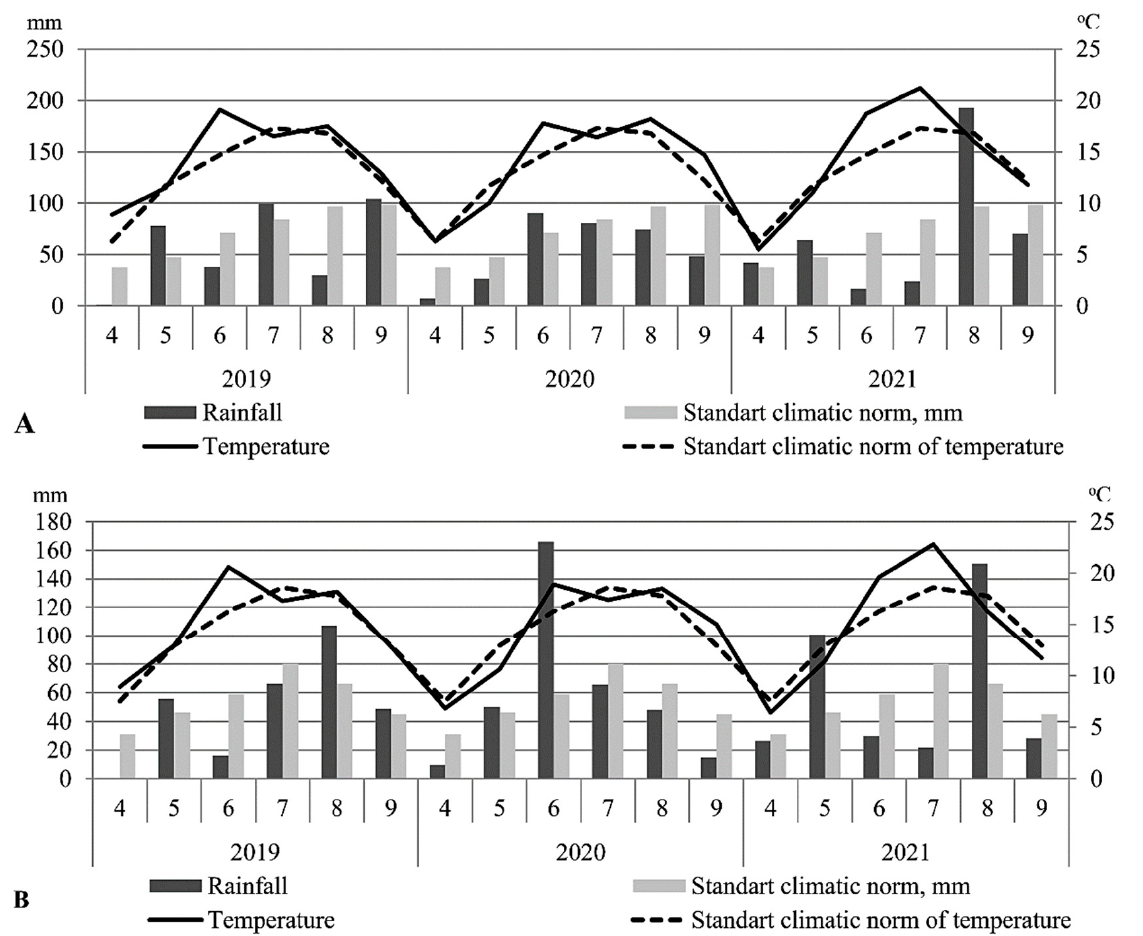
Figure 1. The meteorological conditions of the experimental sites from 2019 to 2021 (data from the V ė žai č iai and Dotnuva, Automatical Meteorological Station). ( A ) The western region of Lithuania and ( B ) the central region of Lithuania.